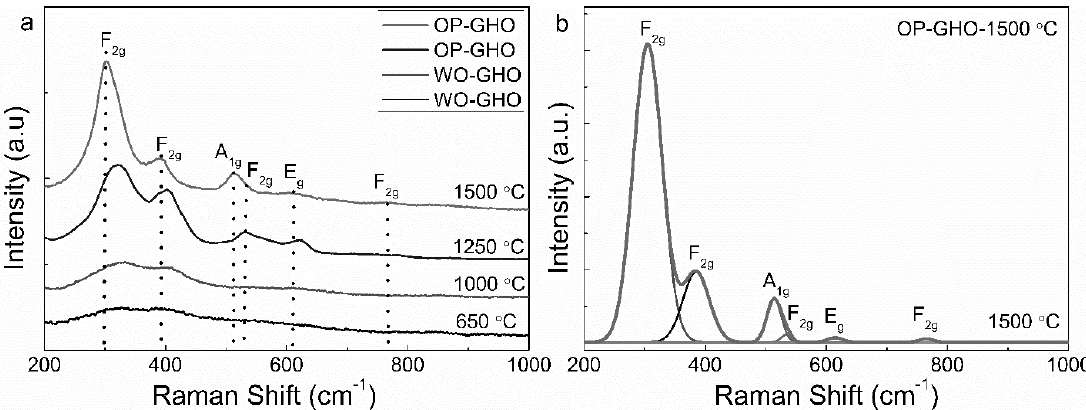
Figure 3. Raman spectra of GHO nanocrystals processed at different temperatures: ( a ) full view; ( b ) the summary of the fitted Raman spectra of the GHO nanocrystals annealed at 1500 °C for 6 h in a box furnace.